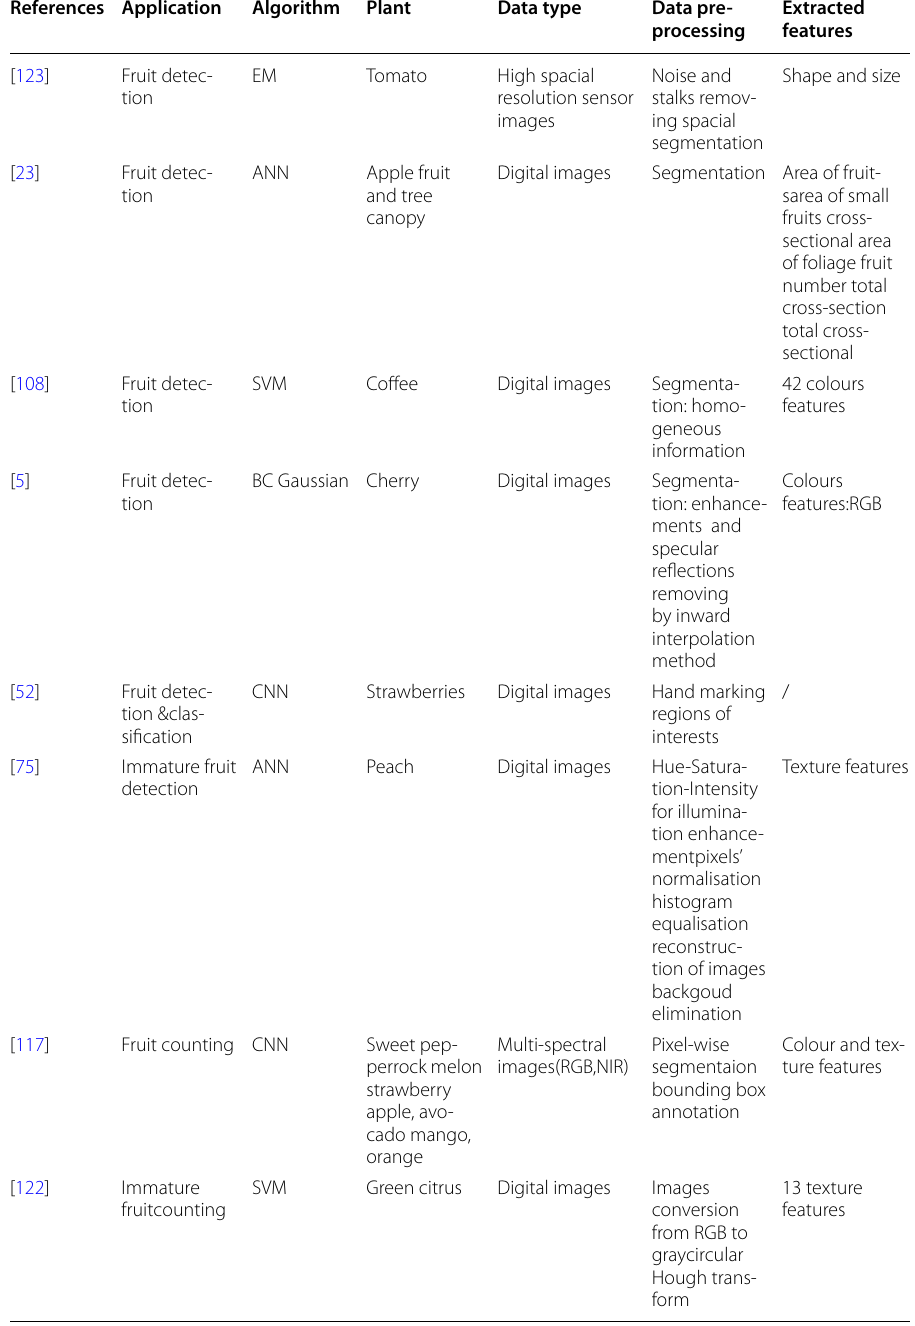
Table 6 An analytical study on examples of crop maturity monitoring (fruits detection and counting) approaches; highlights the applied algorithm, plant and data type, data pre-processing and the extracted